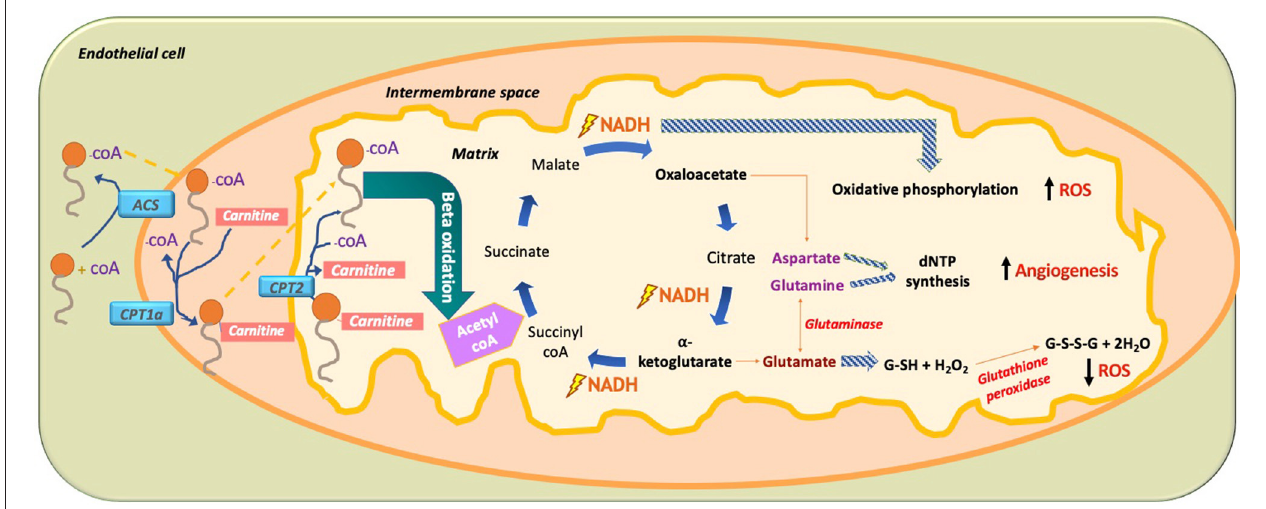
FIGURE 10 | Paradoxical effect of fatty acid (FA) metabolism on ROS production in ECs. In ECs, FA become activated by combining with CoA via acetyl CoA synthetase (ACS) to produce fatty acyl CoA. With the help of mitochondrial outer membrane enzyme carbamoyl palmitoyl-transferase 1a (CPT1a), long-chain fatty acids are transported to the mitochondrial intermembrane space to combine with carnitine, while releasing CoA through CPT1a. This allows FA-carnitine, with the help of CPT2, to move into the matrix of the mitochondria where it again combines with CoA and dissociates from carnitine to produce fatty acyl CoA. Fatty acyl CoA then undergoes beta oxidation to produce 2-carbon acetyl CoA, which is subsequently incorporated into the TCA cycle. There, it produces two main intermediates, oxaloacetate and alpha ketoglutarate, as well as the energy substrate NADH. The paradoxical effect of FA oxidation-mediated ROS production is demonstrated when NADH used in oxidative phosphorylation increases ROS production. Amino acid (AA) glutamate derived from alpha-ketoglutarate is used to produce the hydrogen peroxide oxidizing agent glutathione (GSH), which neutralizes H 2 O 2 and thus reduces ROS. In addition, the AA aspartate (derived from oxaloacetate) and the AA glutamine (derived from the AA glutamate through glutaminase) are used for nucleotide synthesis in EC, thus increasing DNA synthesis and increasing EC proliferation. FA, fatty acid; ACS, acetyl CoA synthetase; CPT1a, carbamoyl palmitoyl transferase 1a; CPT2, carbamoyl palmitoyl transferase 2; NADPH, nicotinamide adenine dinucleotide phosphate; dNTP, deoxynucleoside triphosphate; ROS, reactive oxygen